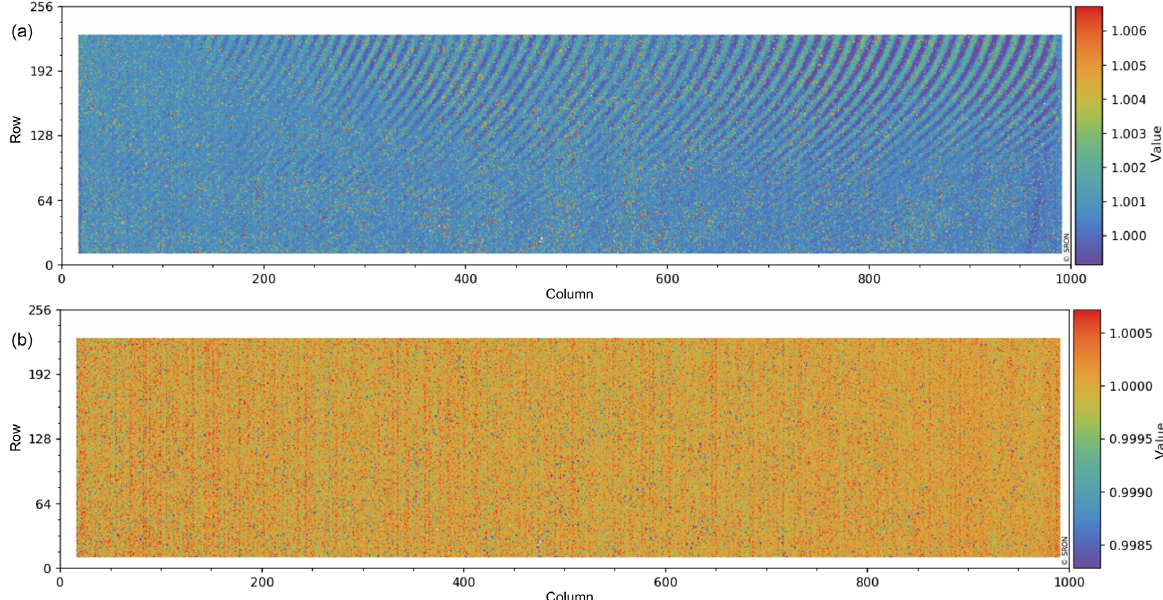
Figure 13. DLED response of orbits 907 (a) and 2707 (b) relative to the in-flight reference of orbit 2515. Note that the change between orbits 2515 to 2707 is